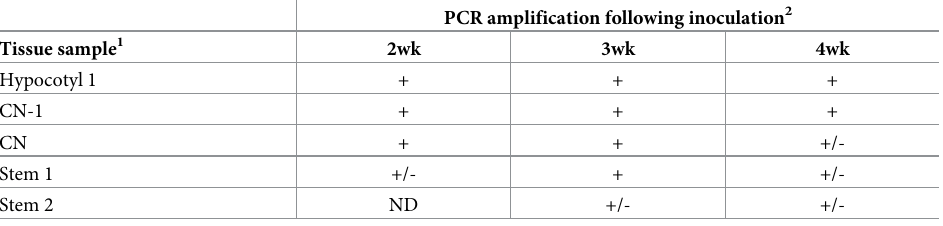
Table 2. Distribution of HOFo isolate MCC2074 based on specific primers Primer 5/ST33-R in ‘Yu-Nyu’ cherry tomato plant tissues following hypocotyl